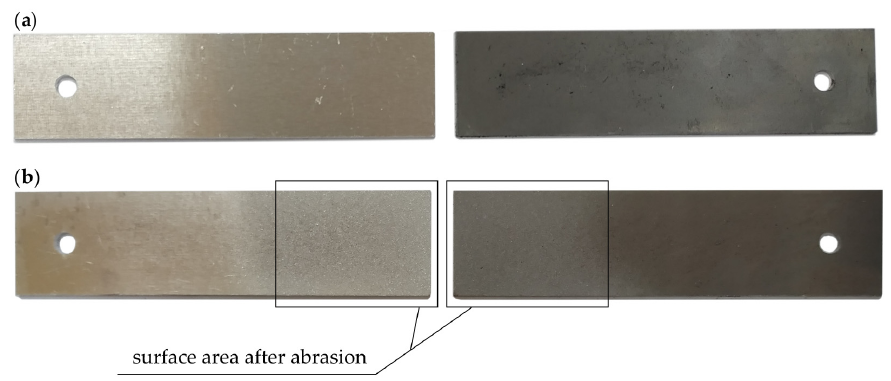
Figure 7. Flat bars to be used in tests: ( a ) accepted for tests, ( b ) after abrasion with electrocorundum.